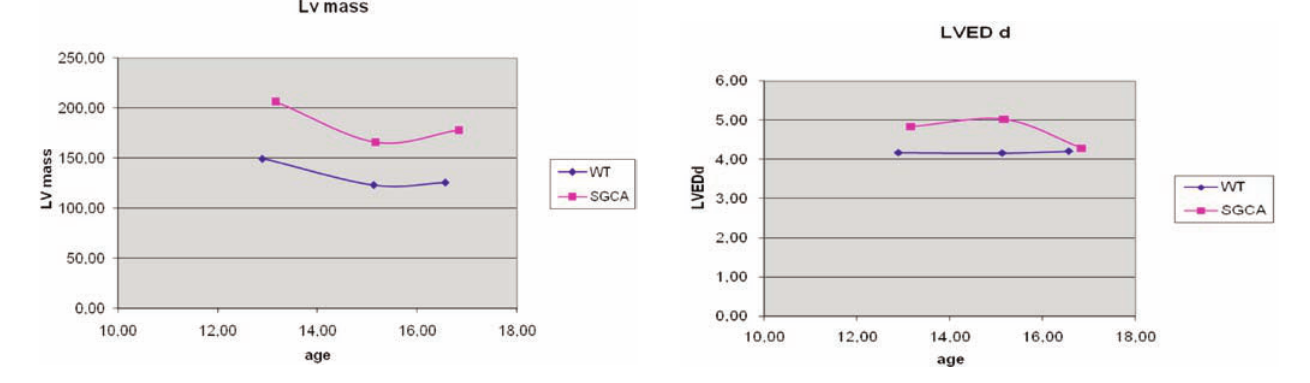
Figure 2. Evolution of the LV mass (mg) from age 13 months to 17 months in sgca-null mice and WT mice. LV mass (unit) = mg, Age = months.